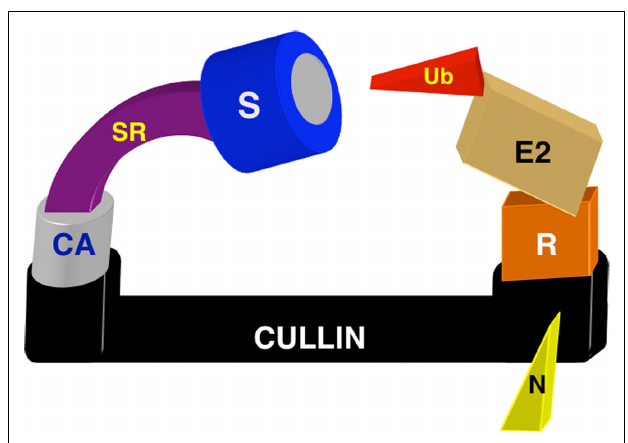
FIGURE 1 | Schematic diagram of the multimeric CRL ubiquitin ligase complex. The elongated cullin scaffold binds cullin-specific adaptors (CA) at the N-terminus to recruit substrates (S). All cullins except CUL3 require separate substrate receptors (SR) to bridge the adaptor–substrate interaction. RING protein adaptors (R) bind the ubiquitin (Ub)-charged E2 conjugating enzyme at the cullin C-terminus. Nedd8 post-translational modification (N) promotes cullin